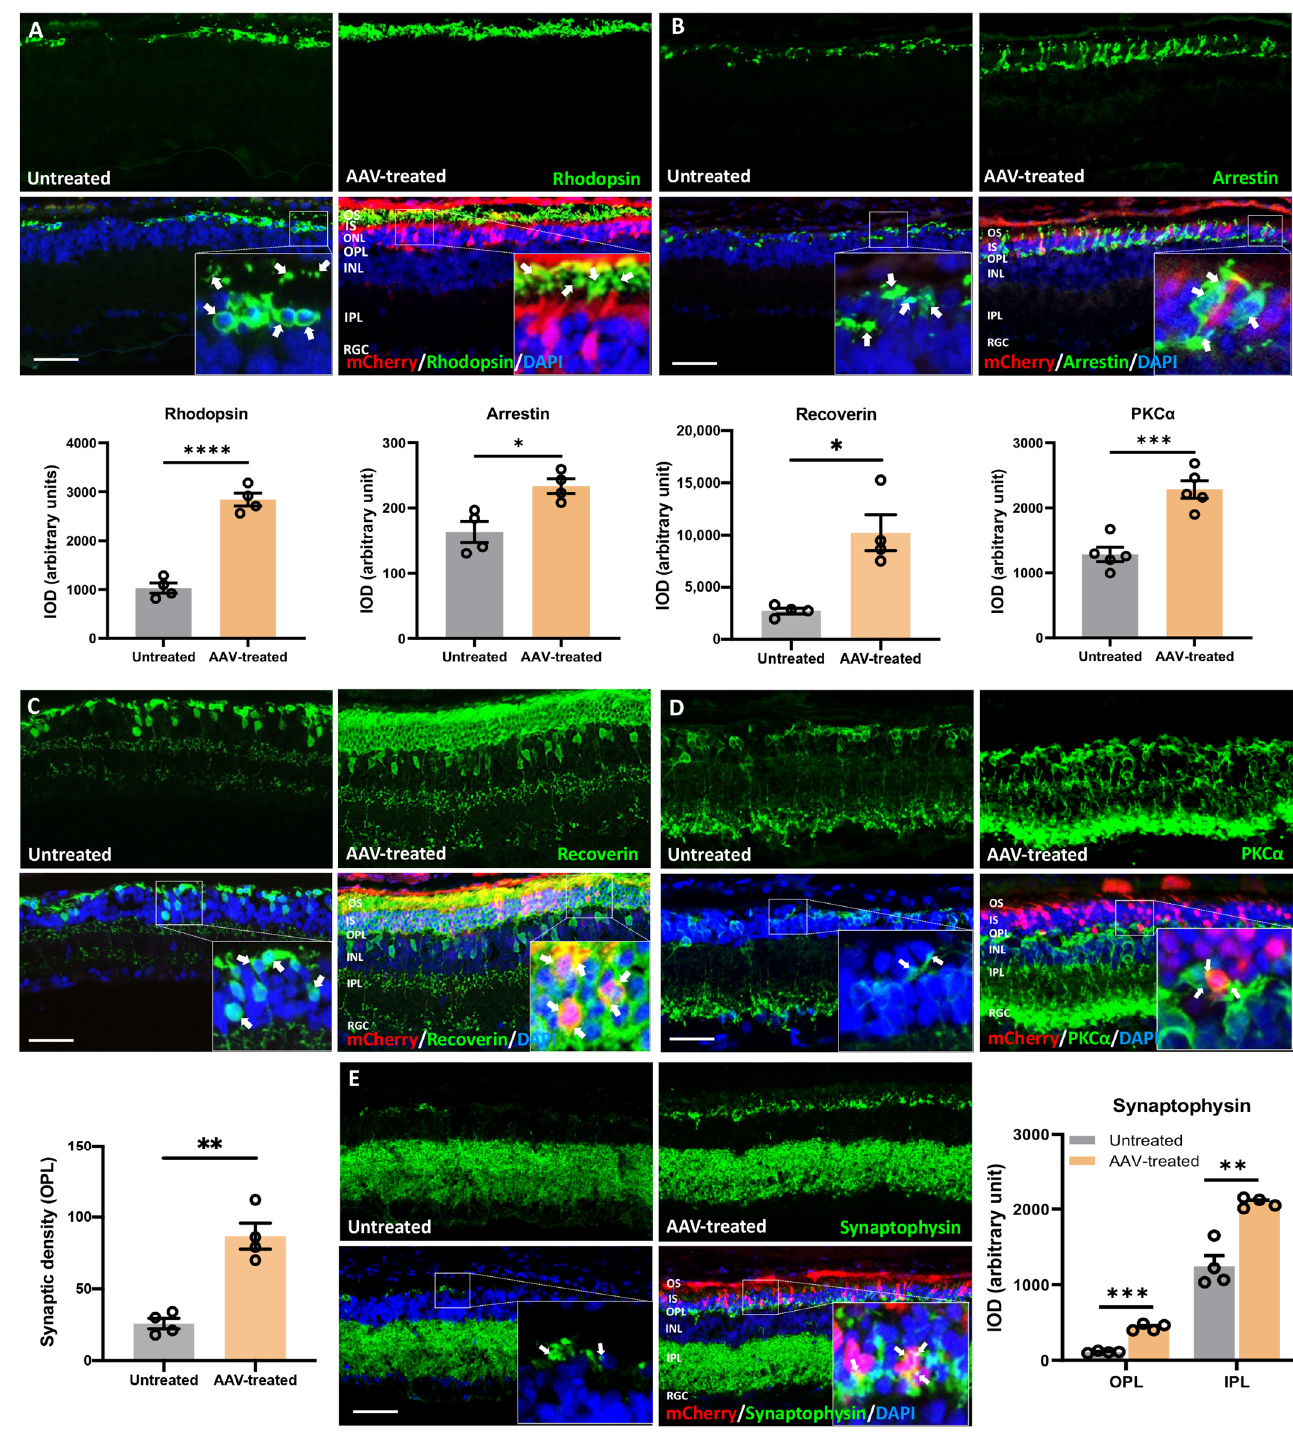
Figure 5. Preservation of rod and cone photoreceptors, rod-bipolar dendritic arborization, and retinal synapses following m- Rho P23H ablation. Retinal sections from P450 P23H rats were processed for immunofluorescence (IF) using antibodies against rhodopsin ( A ), cone arrestin ( B ), recoverin ( C ), PKC α ( D ) and synaptophysin ( E ). ( A ) Rhodopsin IF image shows significantly increased expression of (green) PR outer segments (OS) (yellow: green; colocalized with mCherry (red): yellow) in retinal regions proximal to AAV injection compared to the contralateral retina distal to the injection site. In these regions, rhodopsin was restricted to cell bodies, which suggests ER retention of rhodopsin. ( B ) Arrestin IF image of AAV-treated retina shows significantly increased immunofluorescence intensity (green) and number of immunolabeled cones with non-pathological morphological features. Cones were infrequently observed in untreated retinas and were fragmented and irregular shaped,